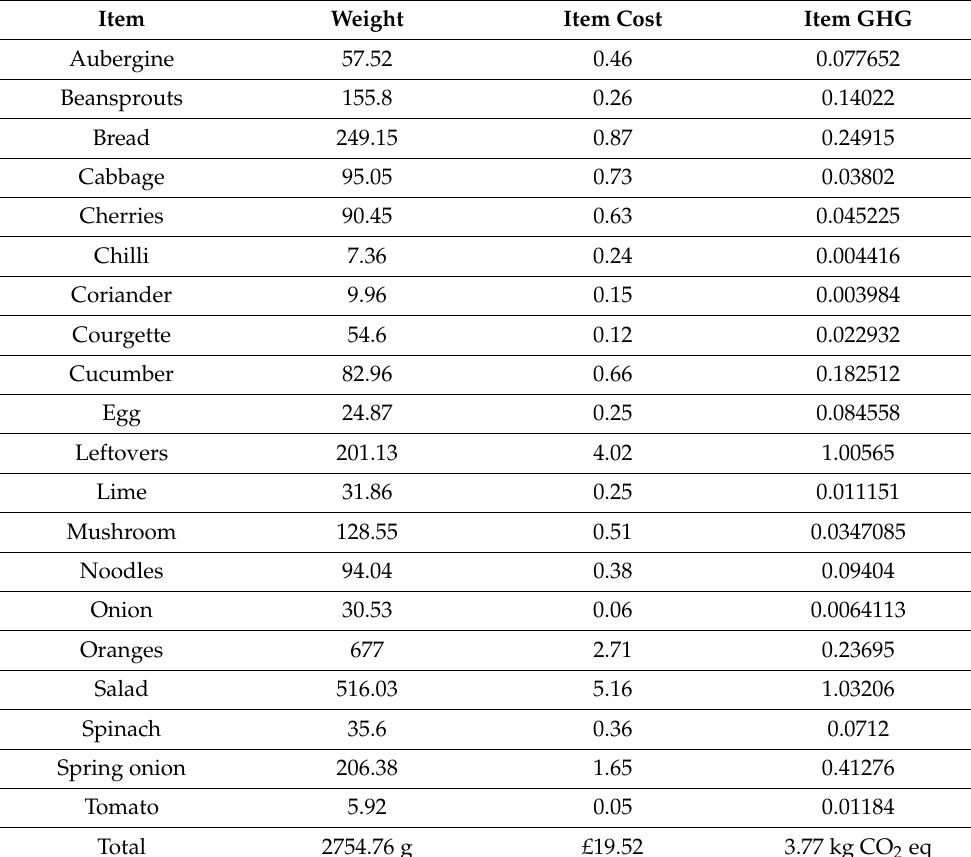
Table A1. Household 3’s avoidable items over the entire